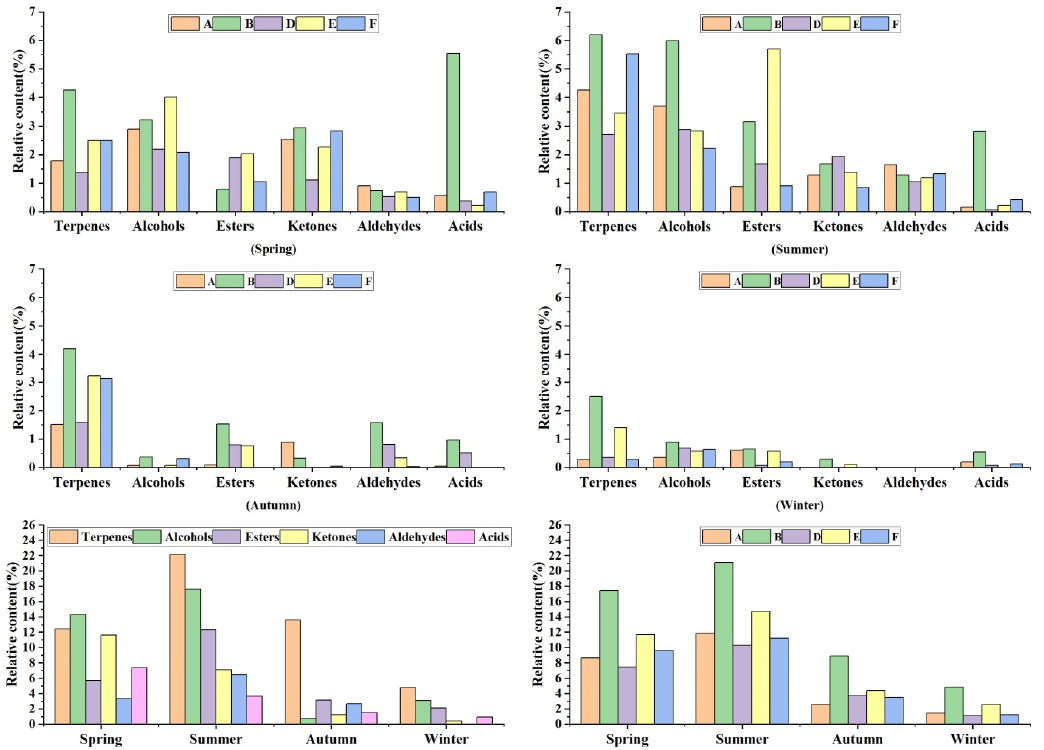
Figure 11. Comparison of phytoncide species and relative content in different forest types. A— Phyllostachys edulis forest; B—Subtropical evergreen broad-leaved forest; C—Forestless control group; D— Liquidambar formosana forest; E— Cunninghamia lanceolata forest; F—Coniferous and broad-leaved mixed forest. Table 5. Relative content of phytoncide